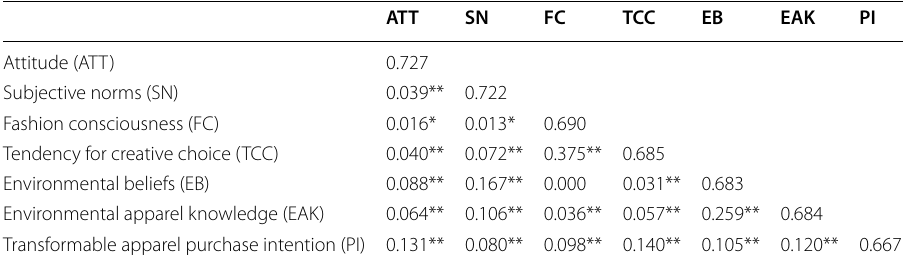
Table 2 Correlation matrix of measurement